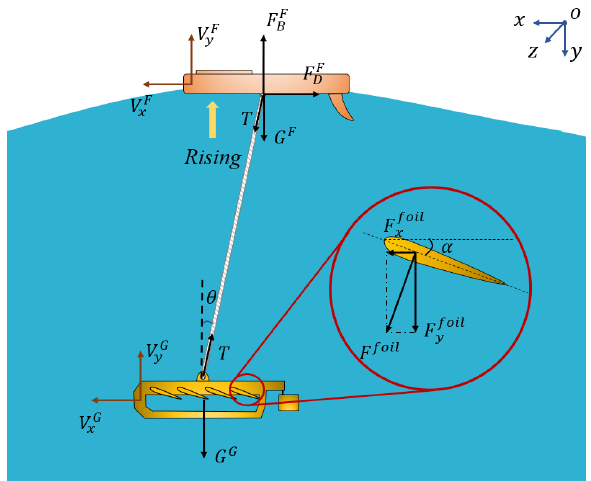
Figure 5. Force analysis diagram of a wave glider.